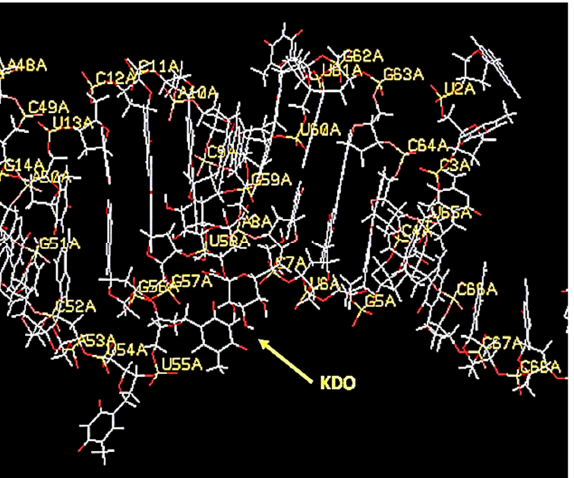
Figure 5. A 3D aptamer stick model in YASARA showing the close proximity of KDO core antigen to specific nucleotides seemingly within the 85–100 Å Förster distance, but when these bases were labeled with fluorophores and quenchers, no beacon responses were noted as a function of increasing KDO or LPS concentrations.